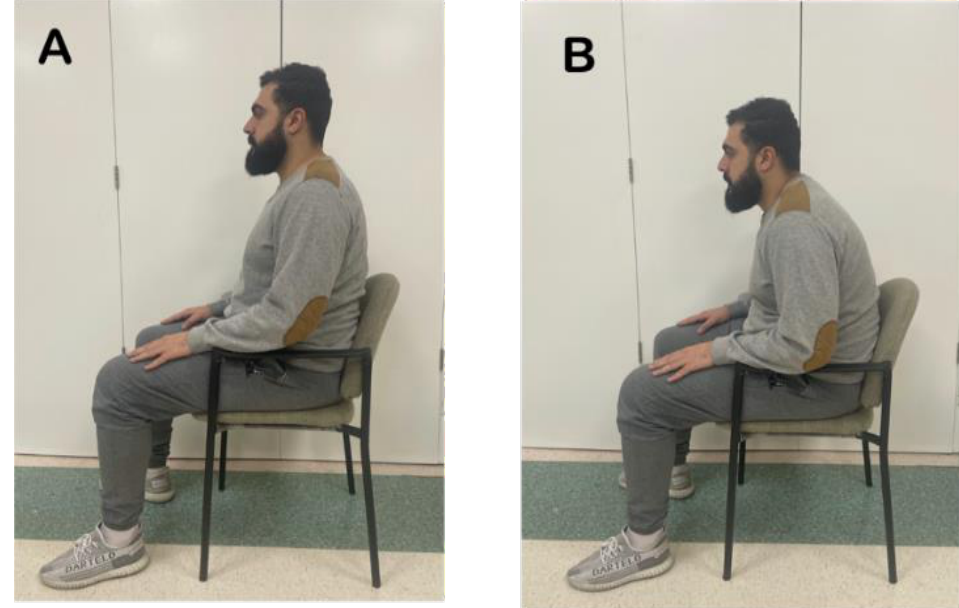
Figure 2. Sitting Positions. ( A ): Erect sitting, ( B ): Slouched sitting.